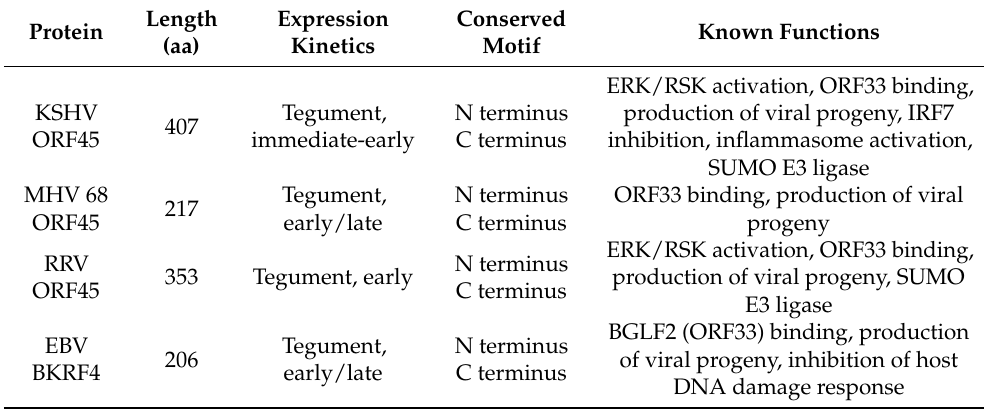
Table 2. Summary of ORF45